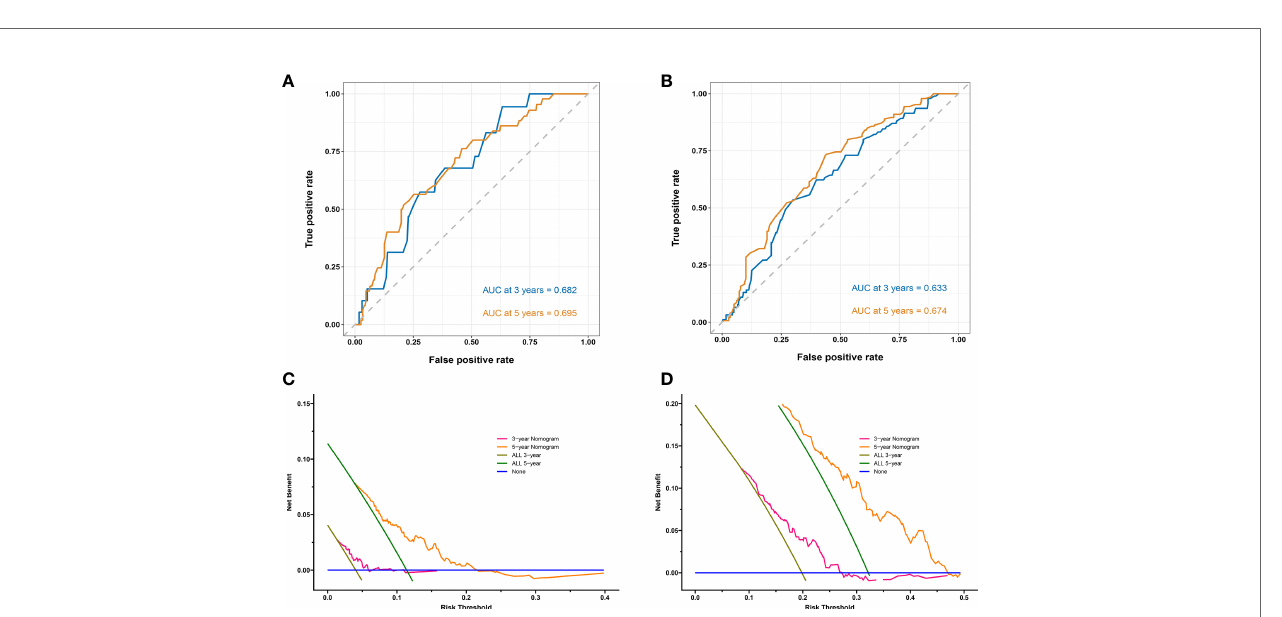
FIGURE 3 | Time receiver operating characteristic (ROC) curves and area under the curve (AUC) for predicting 3-year and 5-year survival rates in stage IB – IIA LUADs. (A) Overall survival (OS); (B) Disease-free survival (DFS). Decision curves for predicting 3- and 5-year survival rates in stage IB – IIA LUADs. (C) OS; (D) DFS. The x-axis represents the threshold probabilities and the y-axis measures the net bene fi t calculated by adding the true positives and subtracting the false positives. The blue line assumes that death or recurrence occurred in no patients. The brown line assumes that all patients will face death or recurrence at a speci fi c threshold probability in 3 years. The green line assumes that all patients will face death or recurrence at a speci fi c threshold probability in 5 years. The pink line represents the net bene fi t of using the nomogram in 3 years. The yellow line represents the net bene fi t of using the nomogram in 5